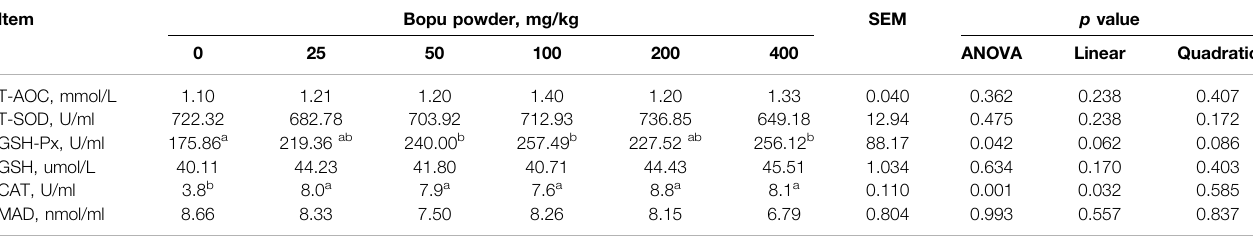
TABLE 4 | Effect of dietary Bopu powder supplementation on serum antioxidant capacity of laying hens. Item